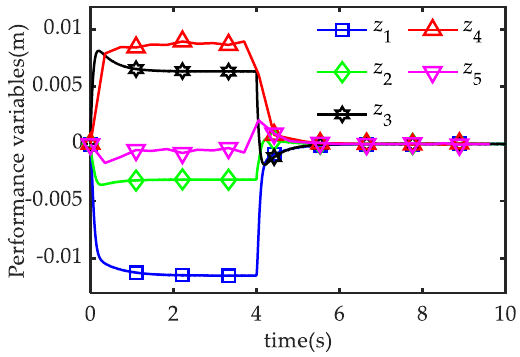
Figure 4. The trajectories of performance variables.